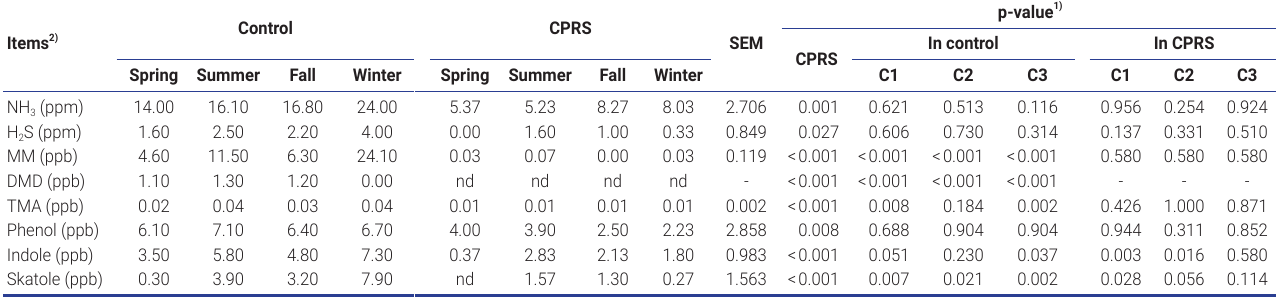
Table 5. Comparison of odorous material contents in the swine barn according to the application of continuous pit recirculation system by the seasons Control Items 2)